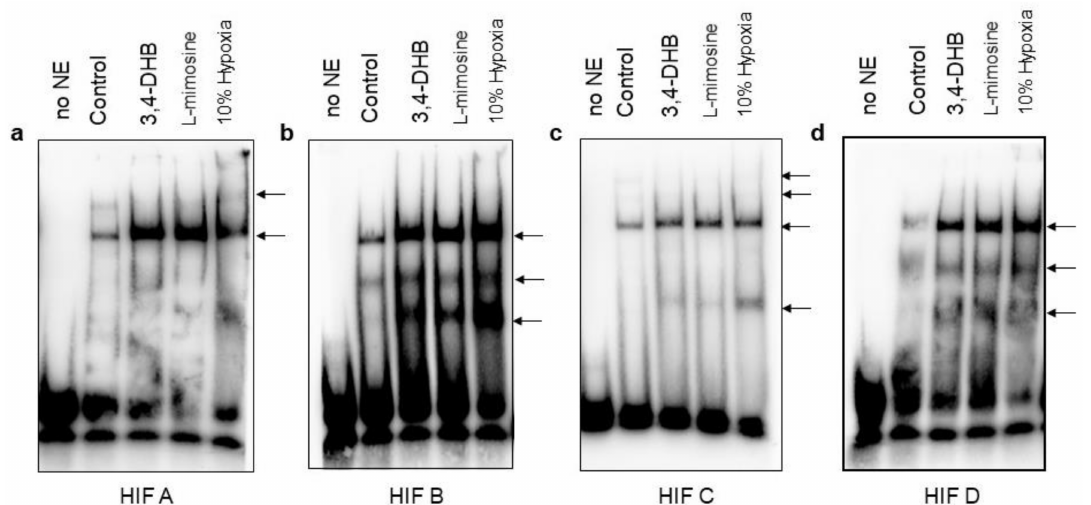
Figure 11. Influence of 10% hypoxia, 3,4-DHB and L-mimosine on the association between nuclear transcription factors and the putative HRE binding sites of the h MORG1 promoter region by EMSA after 24 h treatments. The binding of the nuclear transcription factors to the h MORG1 promoter putative HRE sequences termed HBS A, HBS B, HBS C and HBS D was investigated by EMSA assays using NE purified from HEK 293 cells exposed to 10% hypoxia, 3,4-DHB or L-mimosine for 24 h. Representative images are shown. The detected bands are shown with arrow on the images. ( a ) HBS A. ( b ) HBS B. ( c ) HBS C. ( d ) HBS D. The development of the EMSA gels revealed that the